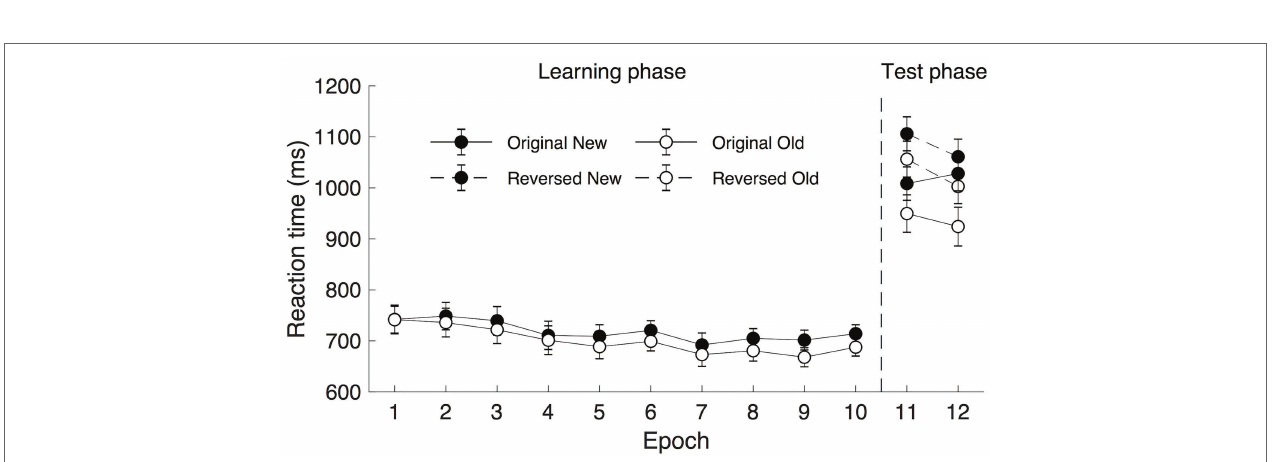
FIGURE 2 | Mean error rates in the learning (epoch 1–10) and the transfer (epoch 11–12) phases as a function of epoch, context, and display type under rapid search display presentation for 300 ms. The error bars represent the within-subject SE of the mean. The black circle lines indicate the new context and the open circle lines indicate the old context. The solid line indicates the original context and the dashed line represents the reversed context.